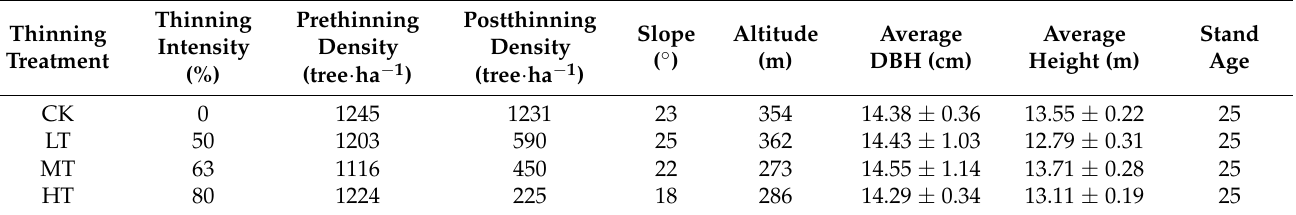
Table 1. Basic information about the four thinning treatments in the Pinus massoniana forests. Data are the mean values ± SEs. DBH: diameter at breast